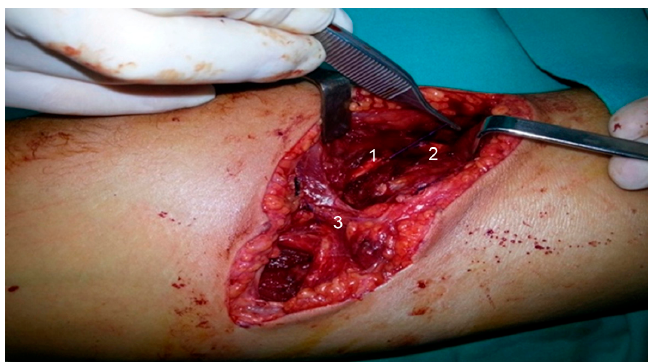
Figure 1. First surgical revision of the wound. Section of the radial nerve, distal tendon and muscle belly of the biceps brachii. 1 : distal end of the radial nerve; 2 : proximal end of the radial nerve; 3 : Lacertus fibrosus.